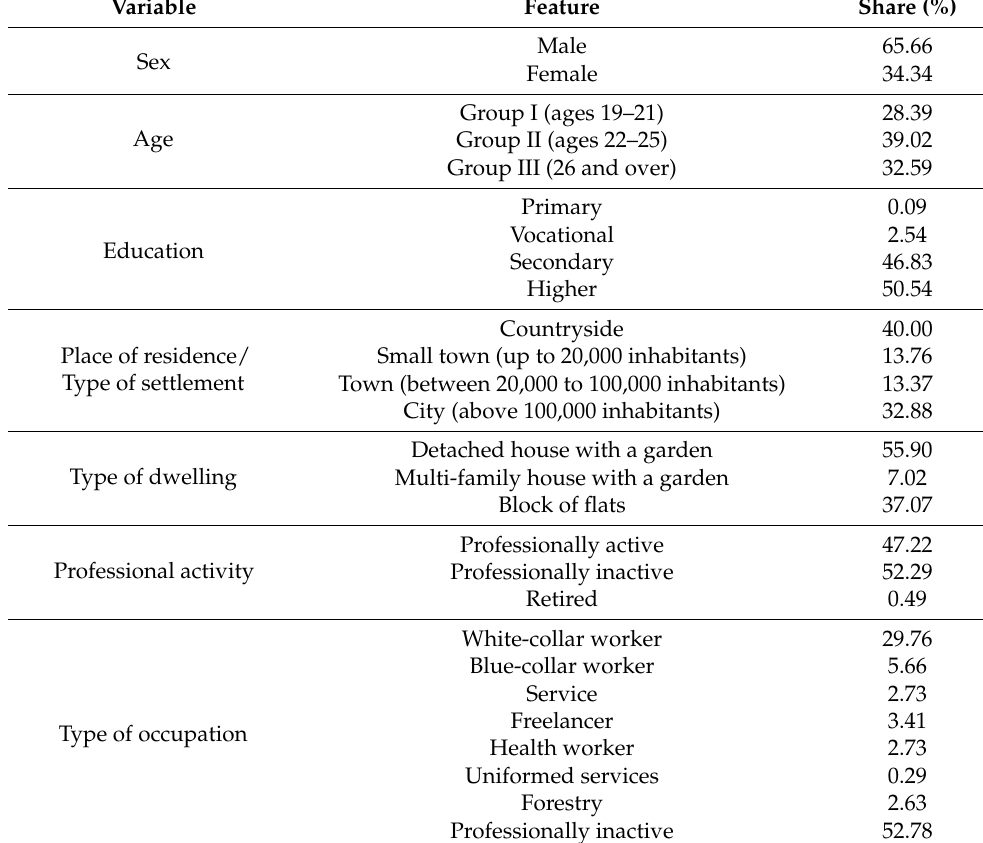
Table 1. Sociodemographic structure of the studied sample.